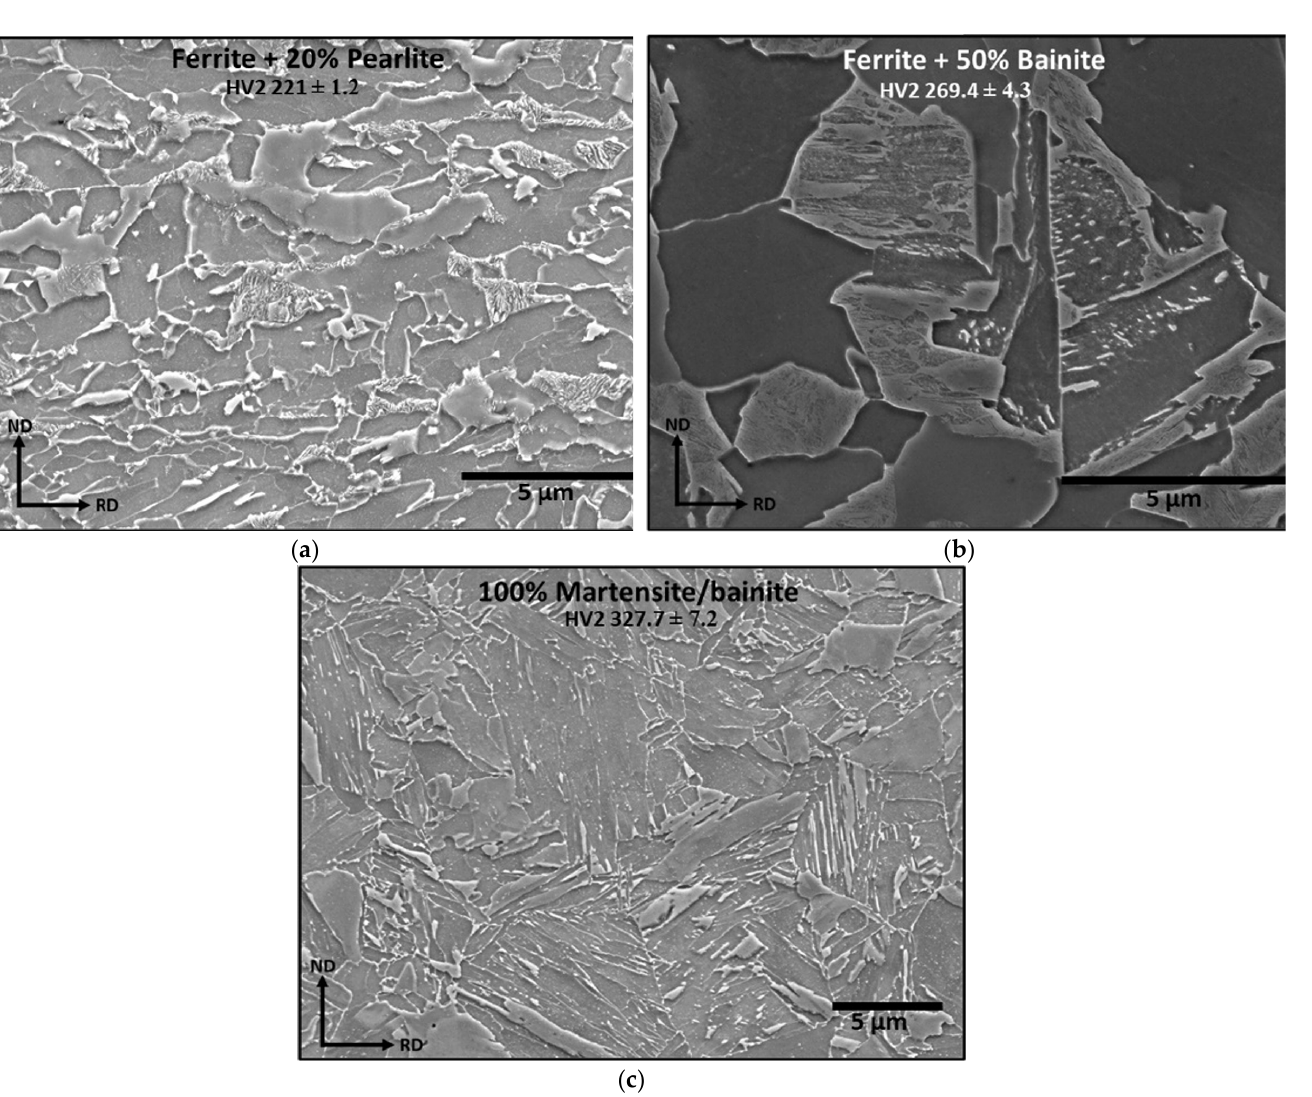
Figure 6. SEM micrographs of hot rolled and simulated coiled (Gleeble) samples with microstructures of ( a ) ferrite–20% pearlite, ( b ) ferrite–50% bainite and ( c ) fully martensite/bainite, respectively, in Variant 2.